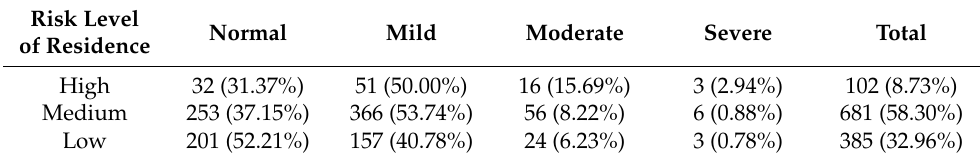
Table 6. The impact of the risk level of the residence on